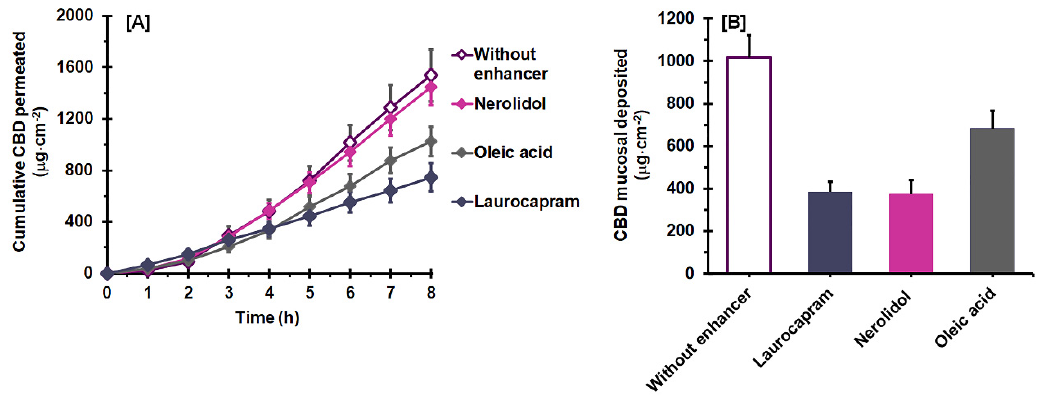
Figure 4. Effect of combined enhancers on ex vivo CBD permeation ( A ) and deposition ( B ) with the 25:75 PG:DEGEE binary vehicle (mean ± SD, n = 4).